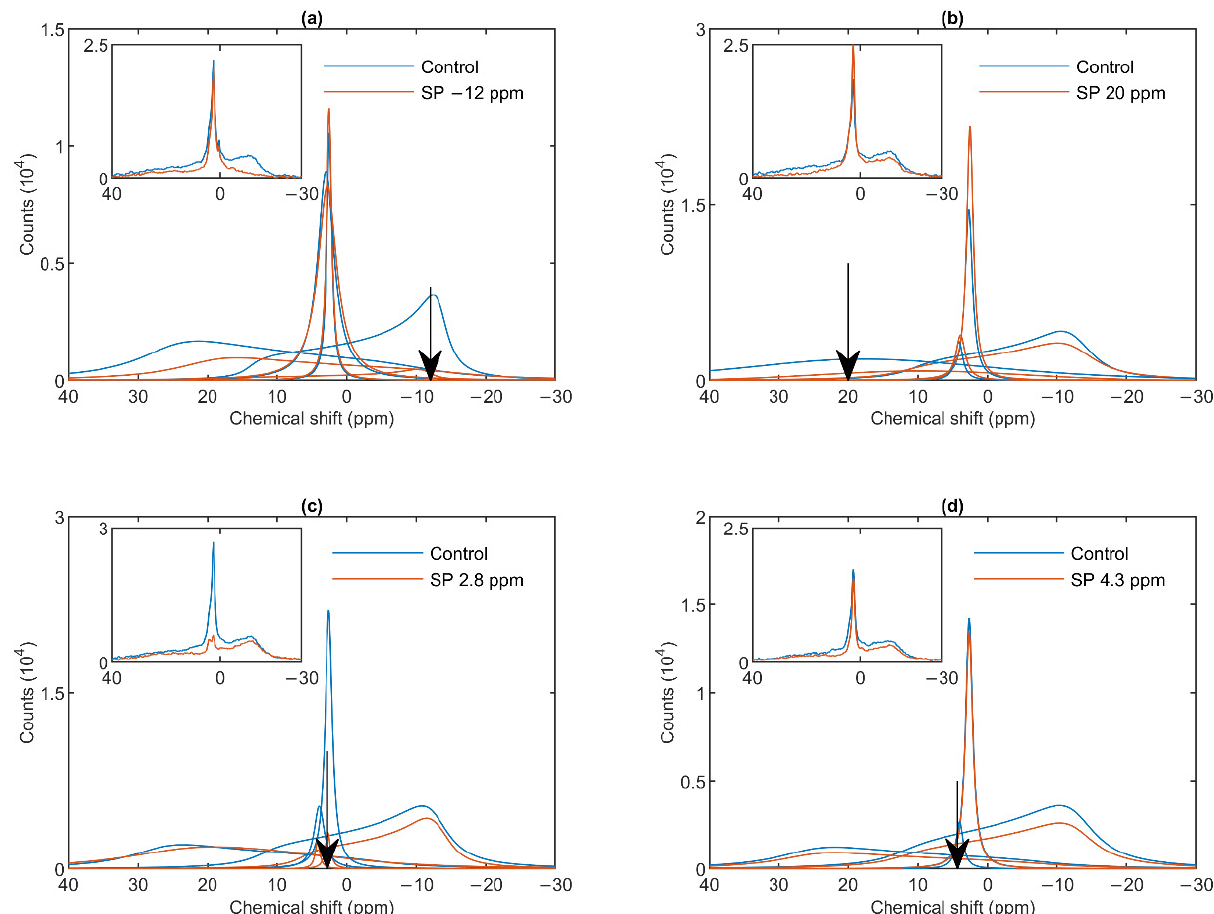
Figure 2. 31 P-NMR spectra of granum thylakoid membranes in the absence (Control, blue curves) and presence (SP, red curves) of saturation pulses applied at different frequencies, as indicated by the arrows, at or close to the peak position of different phases: L, − 12 ppm ( a ); H II , 20 ppm ( b ); I 1 , 2.8 ppm ( c ); I 2 , 4.3 ppm ( d ). Each panel shows the deconvoluted component spectra and, in inset, the measured spectra. The measurements were performed on different batches; the spectra represent averages from two independent batches with similar polymorphisms; temperature, 5 °C.